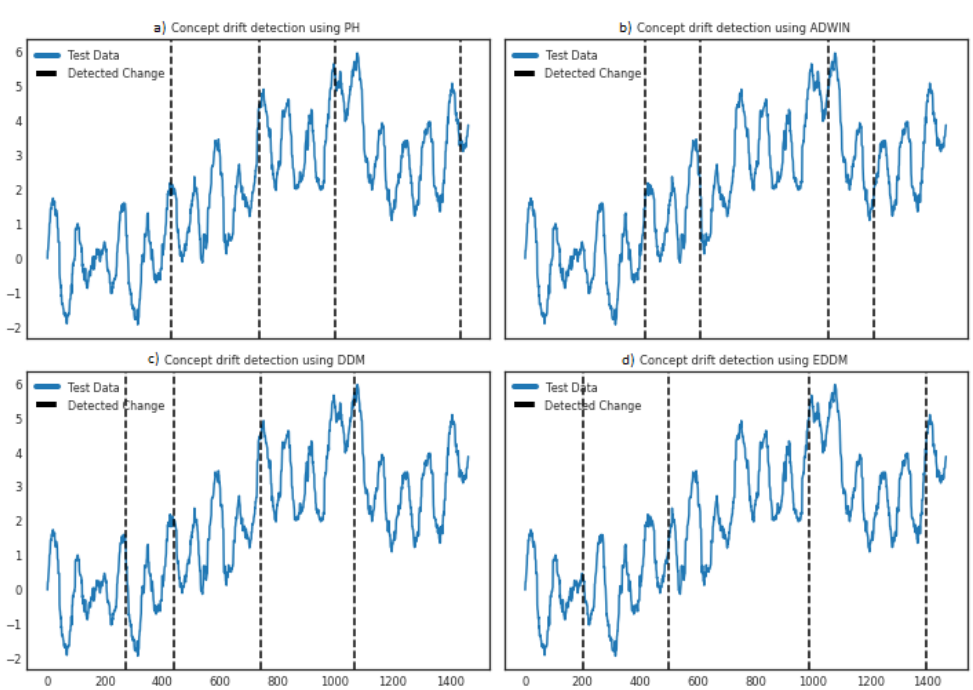
Figure 4. Results for gradual drift detection, see Section 3.1, where X axis shows occurrence count and Y axis the